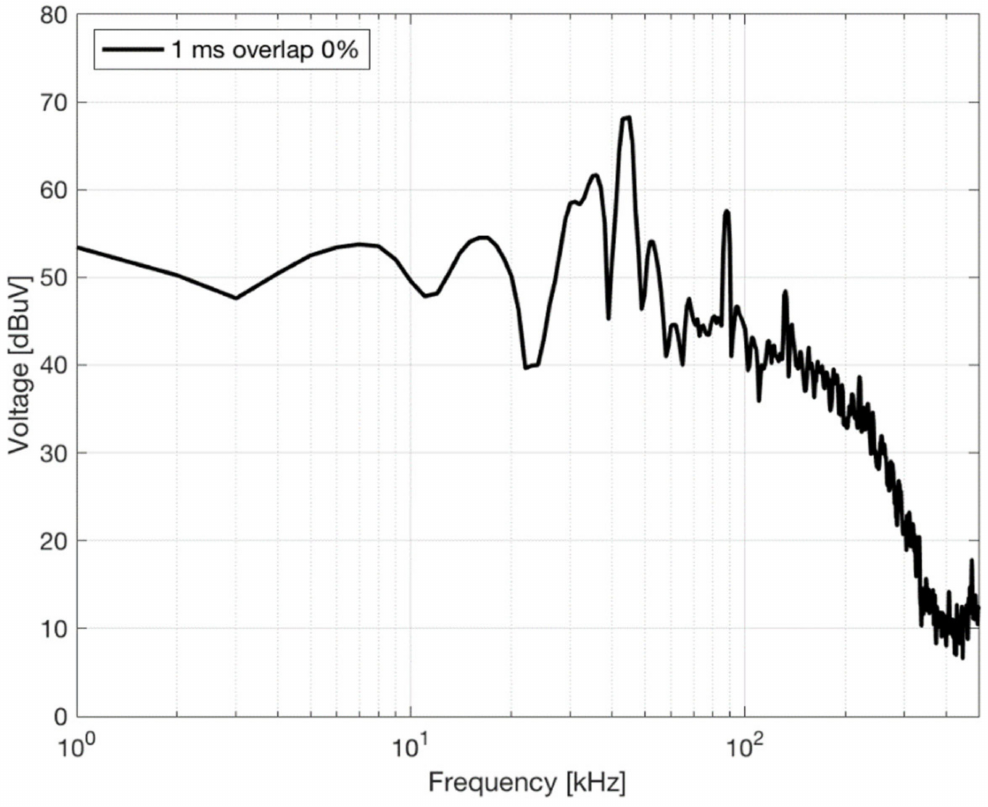
Figure 15. STFT spectrum with ∆ f = 1 kHz and time step ∆ t = 1 ms of the signal resulting from the composition of IMFs 2 and 3 extracted with